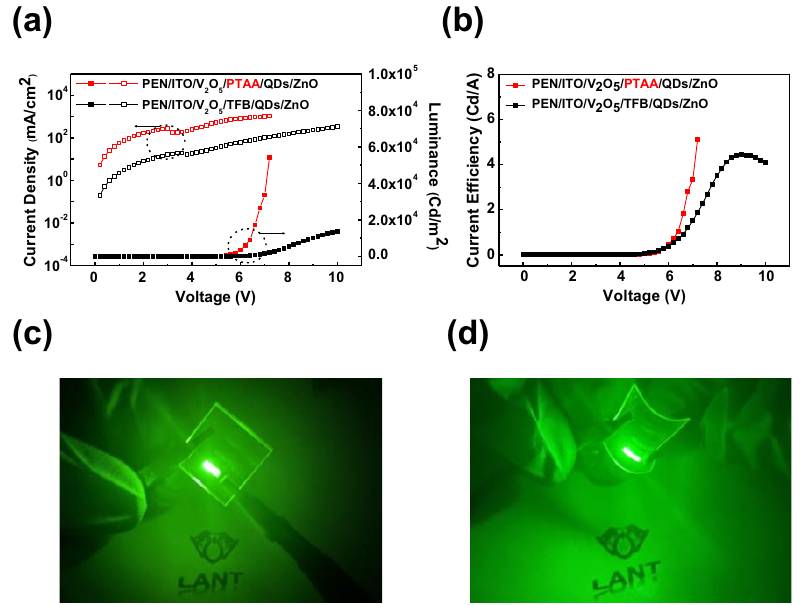
Figure 5. Performance of the QLEDs on the PEN substrate with PTAA and TFB HTLs. ( a ) J-V-L and ( b ) CE-V curves. ( c and d ) Photographs of the flexible QLEDs.